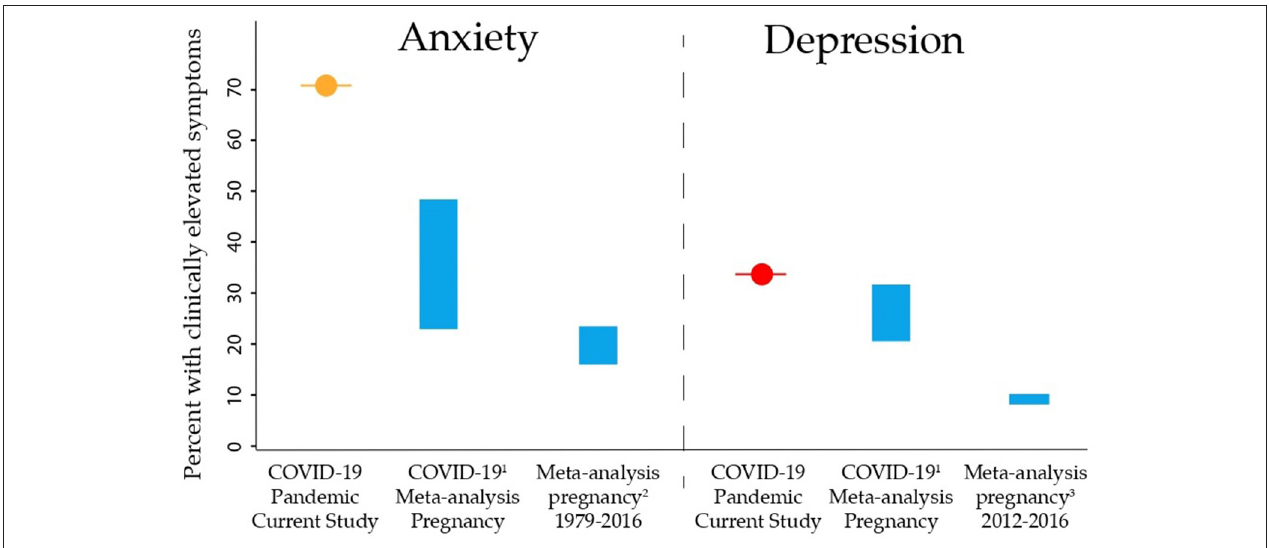
FIGURE 1 | Rates of clinically elevated anxiety and depression symptoms in pregnant individuals in this study were compared to pre-pandemic meta-analysis estimates, and meta-analysis estimates of rates during the COVID-19 pandemic. The prevalence in the current study is given, vs. the estimated ranges in prior studies. The frequency of clinically elevated symptoms of anxiety (orange) and depression (red) in the current study were substantially higher than pre-pandemic and during-pandemic estimates, likely because this data was collected early in the COVID-19 pandemic (April–June 2020) when uncertainty was at its highest. References 1, Tomfohr-Madsen et al. ( 33); 2, Dennis et al. (34); 3, Gavin et al.